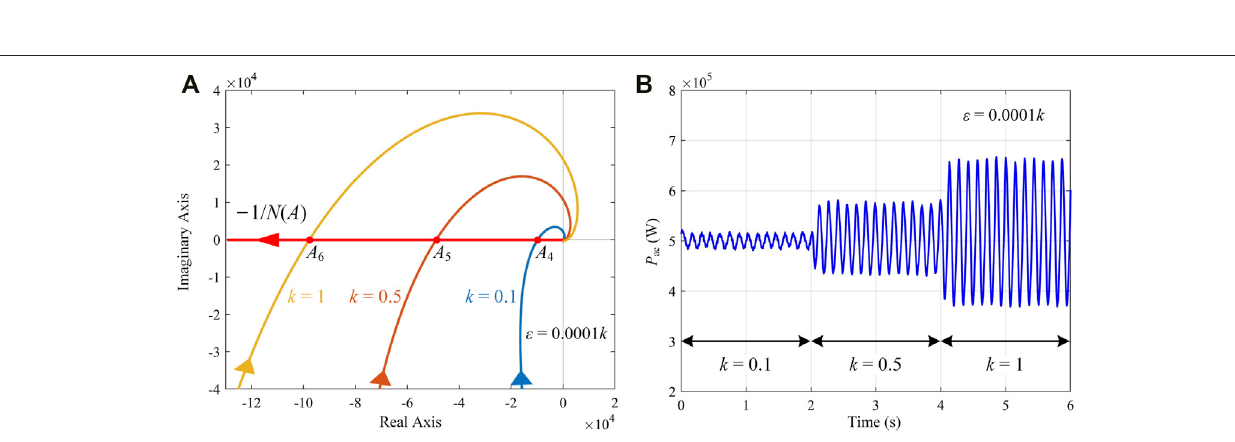
Frontiers in Energy Research |